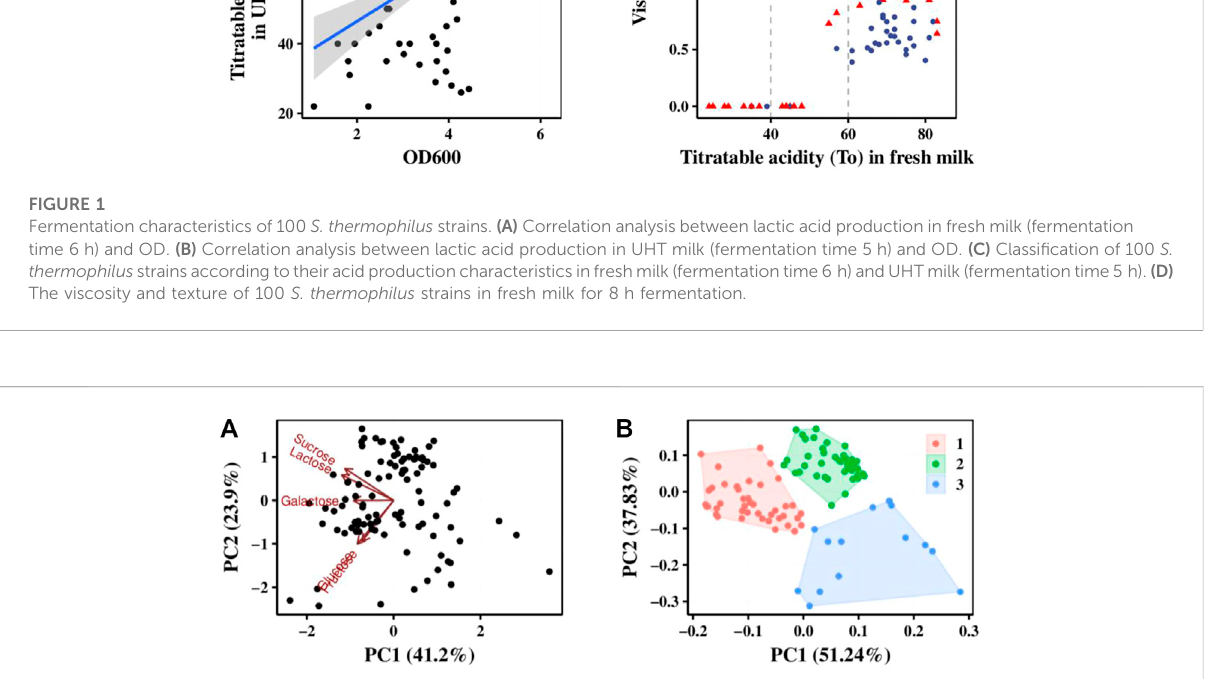
Analysis of 100 S. thermophilus strains by carbon sources use ability. (A) PCA analysis results, the value of coordinate axis PC1/2 is the explanation rate of the overall difference, the arrow represents the original variable, where the direction represents the correlation between the original variable and the principal component, and the length represents the contribution of the original data to the principal component. (B) Strains were divided into three groups according to their utilization of carbon sources by cluster